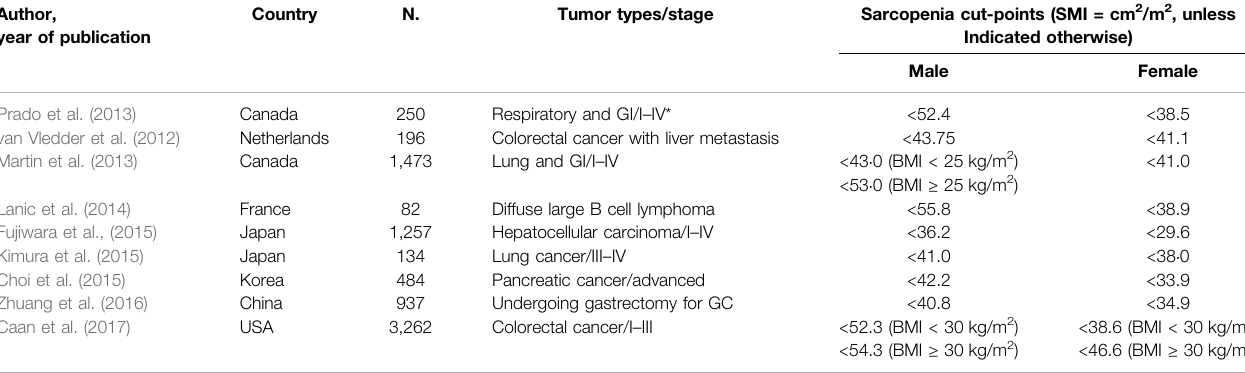
TABLE 2 | Thresholds/cutoff values of skeletal muscle-related parameters partially de fi ned by CT for sarcopenia in tumor